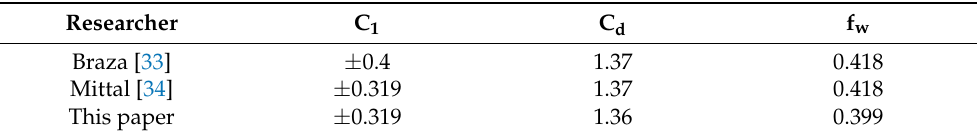
Figure 7. Flow field simulation results of the O–tower: ( a ) time history of the C l and C d ; ( b ) VIV frequency spectrum of the O–tower. Table 2. Reliability verification of the simulation.